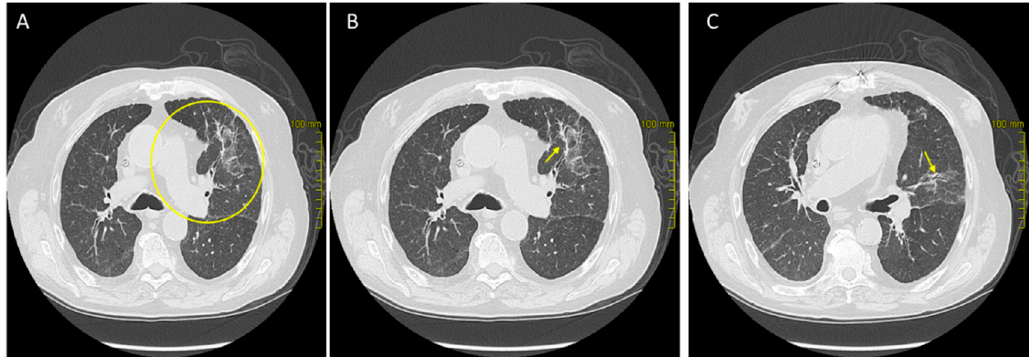
Figure 1. High-resolution computer tomography (HR-CT): ( A ) Thickening of the interlobular septa. ( B ) Patchy ground-glass opacity. ( C ) Lingula ground glass opacity.